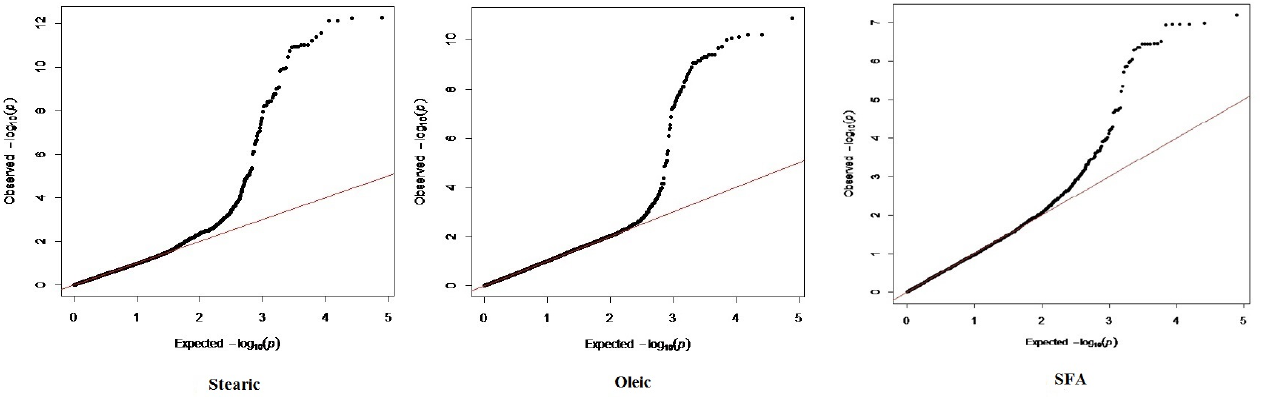
Figure 1. Quantile-quantile (Q-Q) plots of SNP markers in genome wide association study of fatty acid composition. A, B, and C represents stearic, oleic, and saturated fatty acid (SFA),